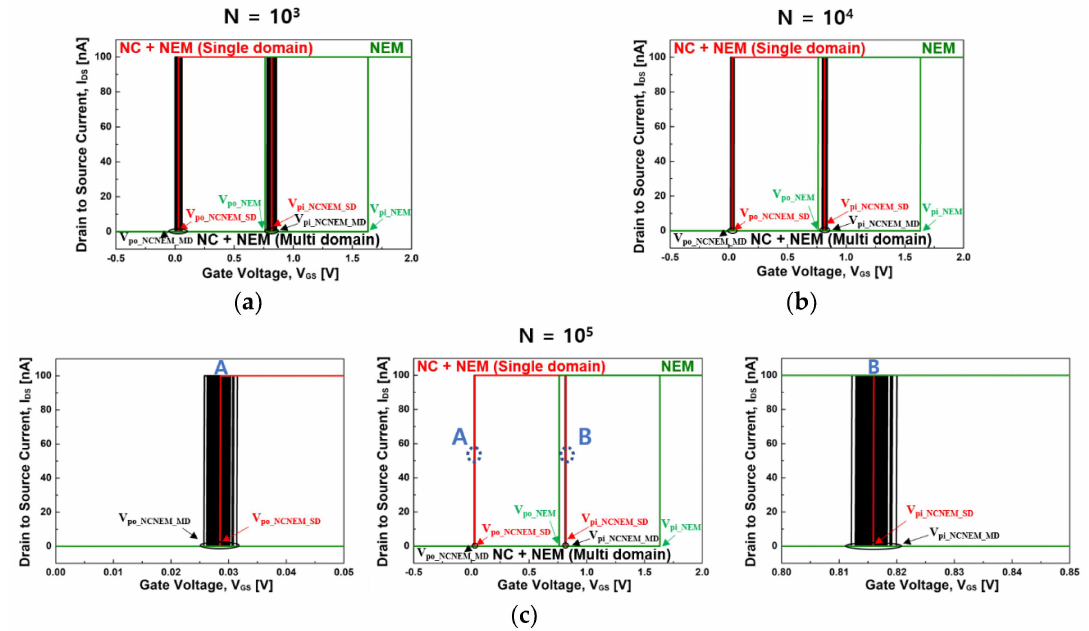
Figure 4. Simulated drain to source current vs. gate voltage of NEM relay, NEM relay with single-domain ferroelectric and NEM relay with multi-domain ferroelectric containing ( a ) 10 3 domains, ( b ) 10 4 domains and ( c ) 10 5 domains. Note that the pull-in / -out voltage of NEM relay (i.e., V pi _ NEM and V po_NEM ), pull-in / -out voltage of NEM relay with single-domain ferroelectric material ( V pi_NCNEM_SD and V po_NCNEM_SD ) and pull-in / -out voltage of NEM relay with multi-domain ferroelectric material